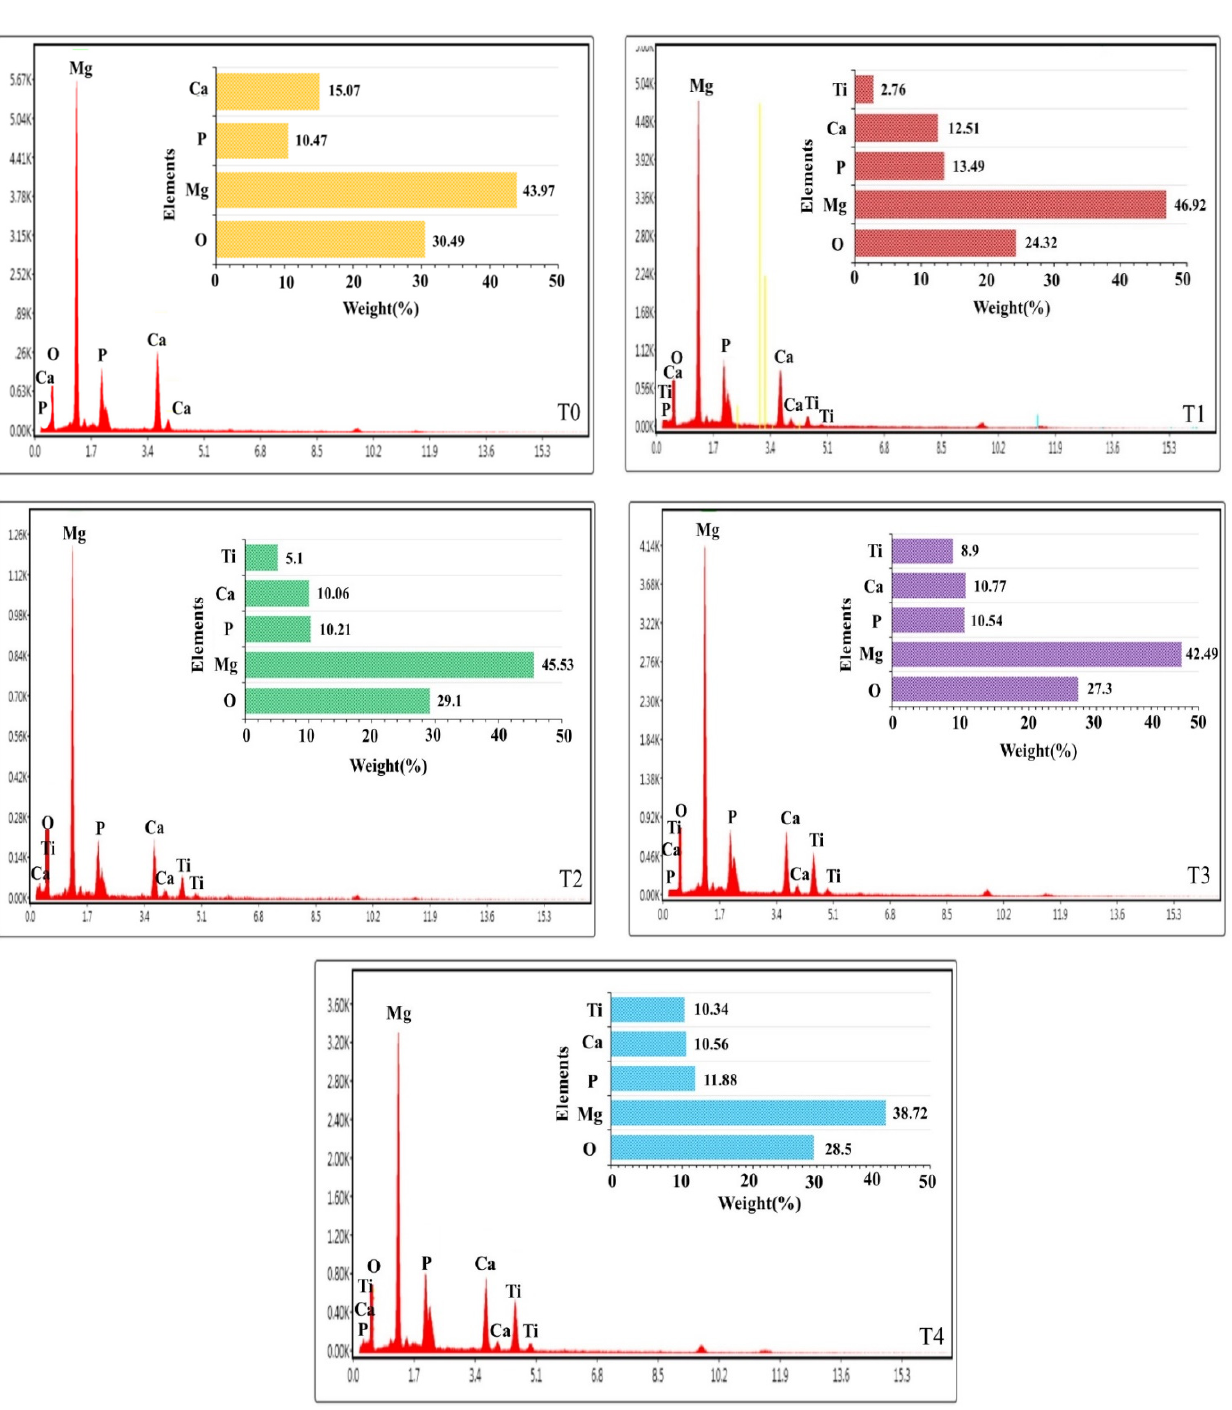
Figure 7. The EDS point spectra of PEO-coated specimens at various concentrations of TiO2: T0= 0 g/L, T1= 1 g/L, T2= 2 g/L, T3= 3 g/L, and T4= 4 g/L.